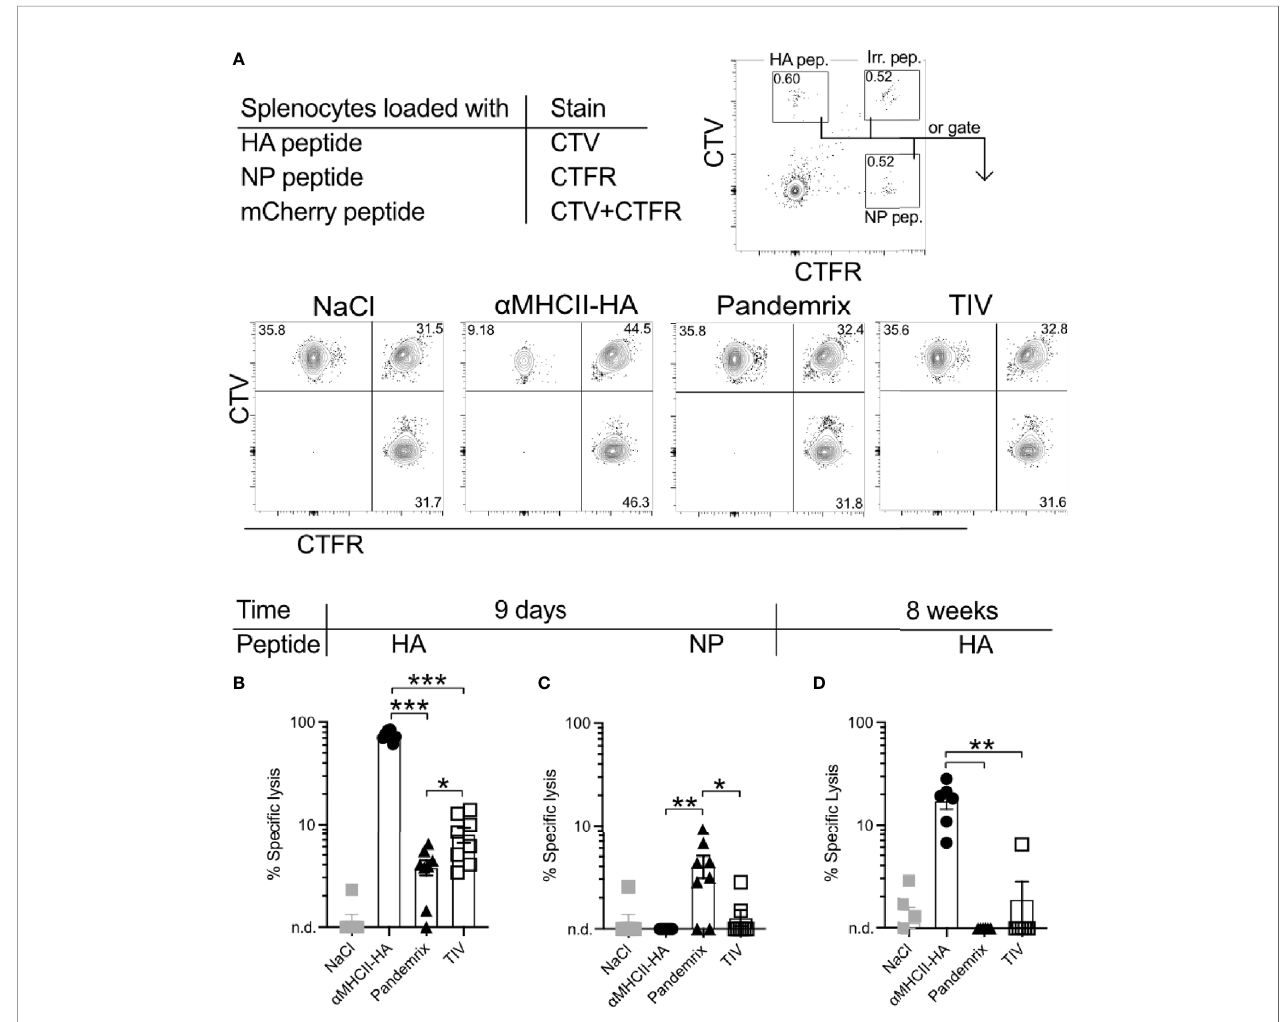
FIGURE 5 | Short and long-term antigen-speci fi c cytotoxic responses after vaccination. Mice (n=6-8/group) were vaccinated once i.m. with the indicated vaccines. After 9 days or 8 weeks, splenocytes from naïve mice were loaded with MHC class I restricted peptides from HA (IYSTVASSL), NP (RLIQNSLTIERMVLS), or irrelevant peptide. Cells were stained with CellTrace Violet (CTV), CellTrace Far Red (CTFR), or double stained with CTV and CTFR, respectively. Cells were mixed in equal ratios and injected i.v. to vaccinated mice. 16h later, spleens were harvested and the presence of peptide loaded splenocytes were assessed by fl ow cytometry. (A) Gating strategy for identi fi cation of transferred cells. (B) HA-speci fi c lysis of splenocytes 9 days after vaccination. (C) NP-speci fi c lysis of splenocytes 9 days after vaccination. (D) HA- speci fi c lysis of splenocytes 8 weeks after vaccination. Data shown are mean ± SEM, *P < 0.05, **P < 0.01, ***P < 0.001